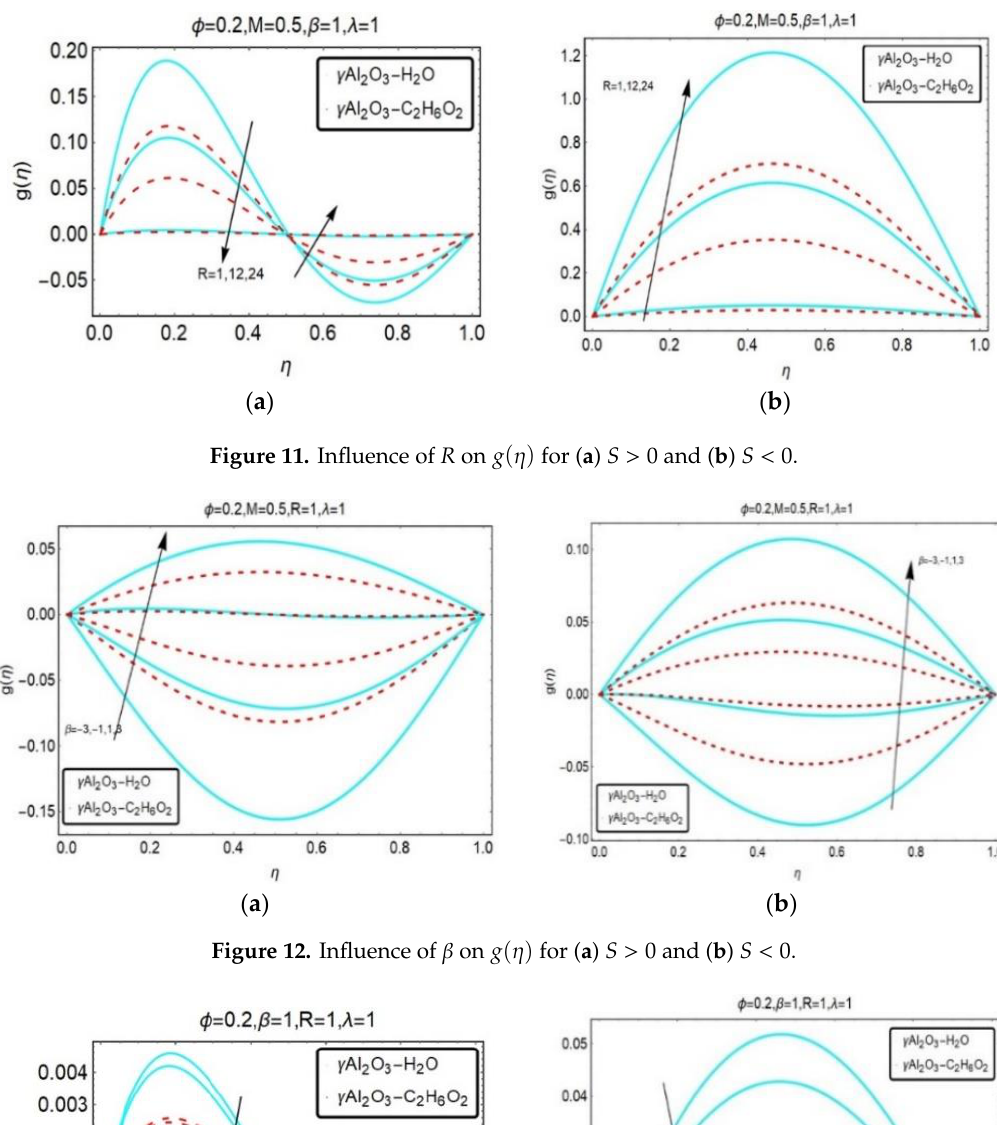
Figure 14. Influence of 𝜆 on 𝑔(𝜂) for ( a ) 𝑆 > 0 and ( b ) 𝑆 < 0.